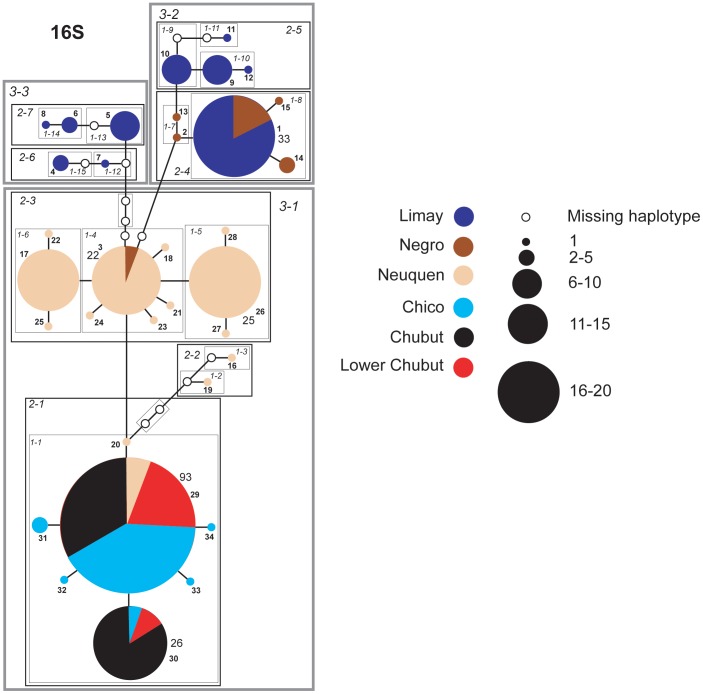
Haplotype network with nested clade design for mtDNA (16 S) sequence data comprised of all samples.Haplotype circle size is proportional to its frequency. Each haplotypes is numbered. Haplotypes that exceed twenty individuals are labeled with the total number of individuals of that haplotype. Arrow indicates the root haplotype. Black empty circles represent extinct (or unsampled) haplotypes. Color codes indicate the six major rivers.